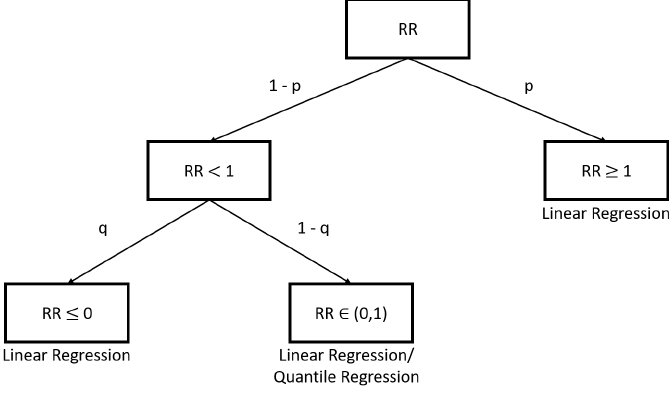
Figure 1. Structure of the decision tree